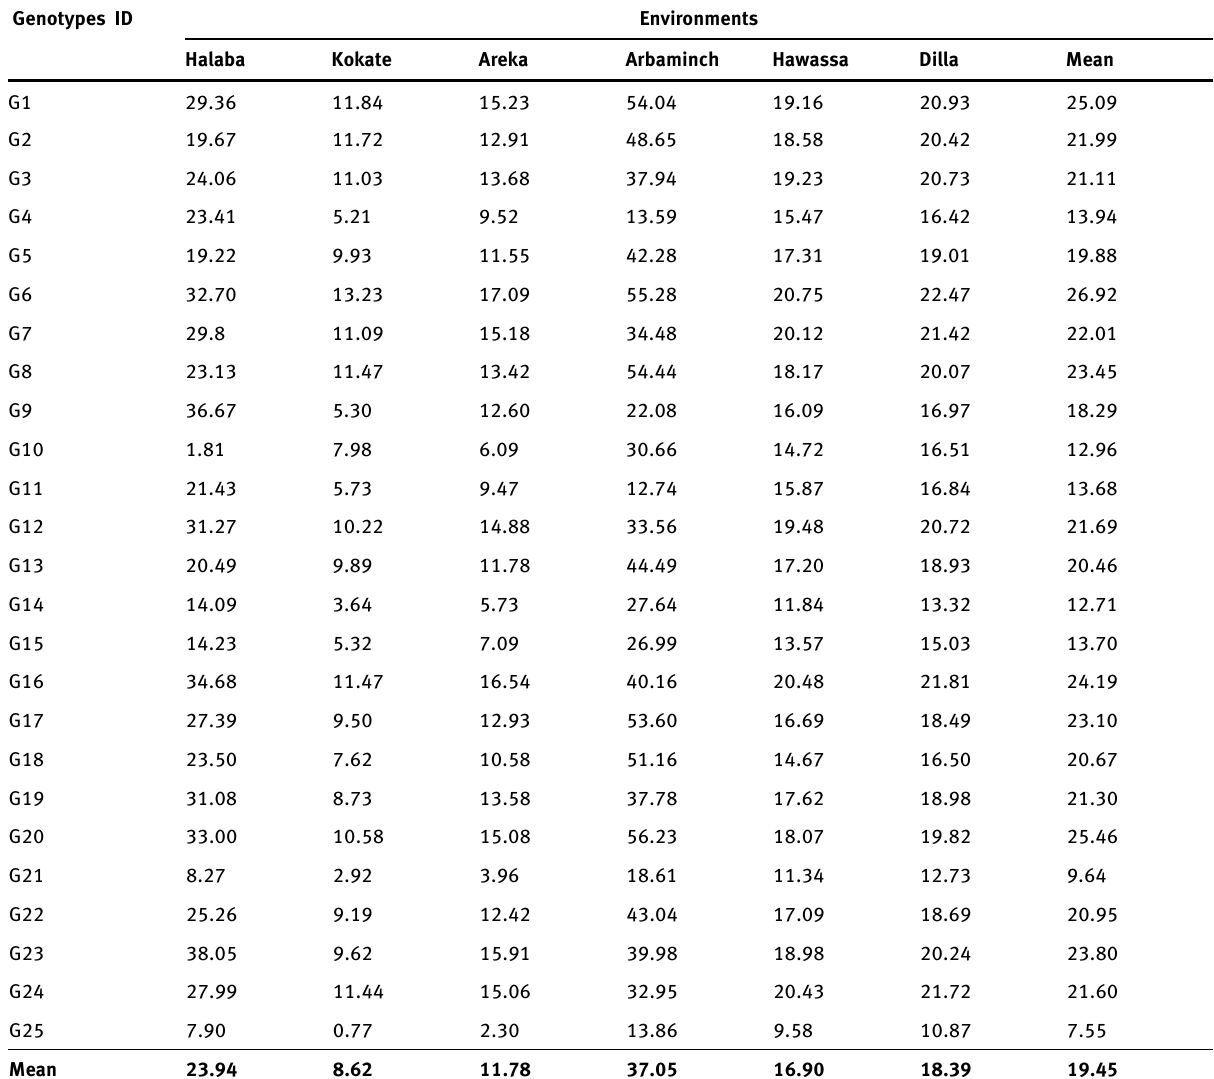
Table 6: Mean fresh root yield (t ha -1 ) of sweetpotato genotypes evaluated across six environments Genotypes ID Environments